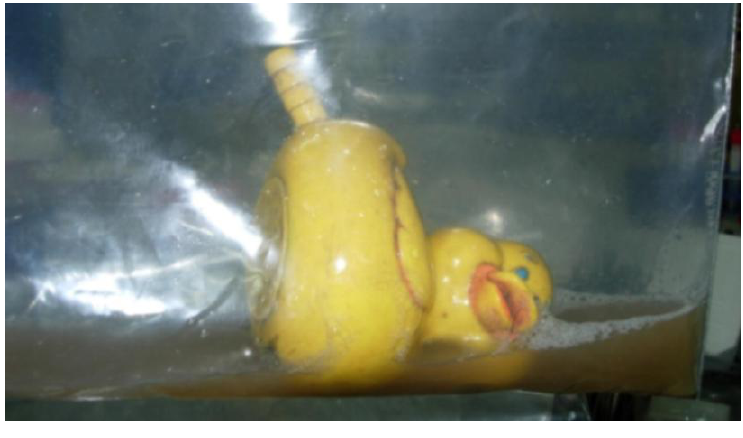
Figure 1: Example of sample collection bag with toy in wash